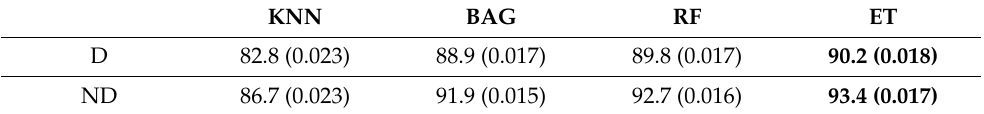
Table 5. Classification result—accuracy (standard deviation)—for dominant (D) and non-dominant (ND) hands gestures, using 60 features and different non-linear classifiers including k-nearest neigh- bors (KNN), bagged decision trees (BAG), random forest (RF), and extra trees (ET) classifiers. KNN BAG RF